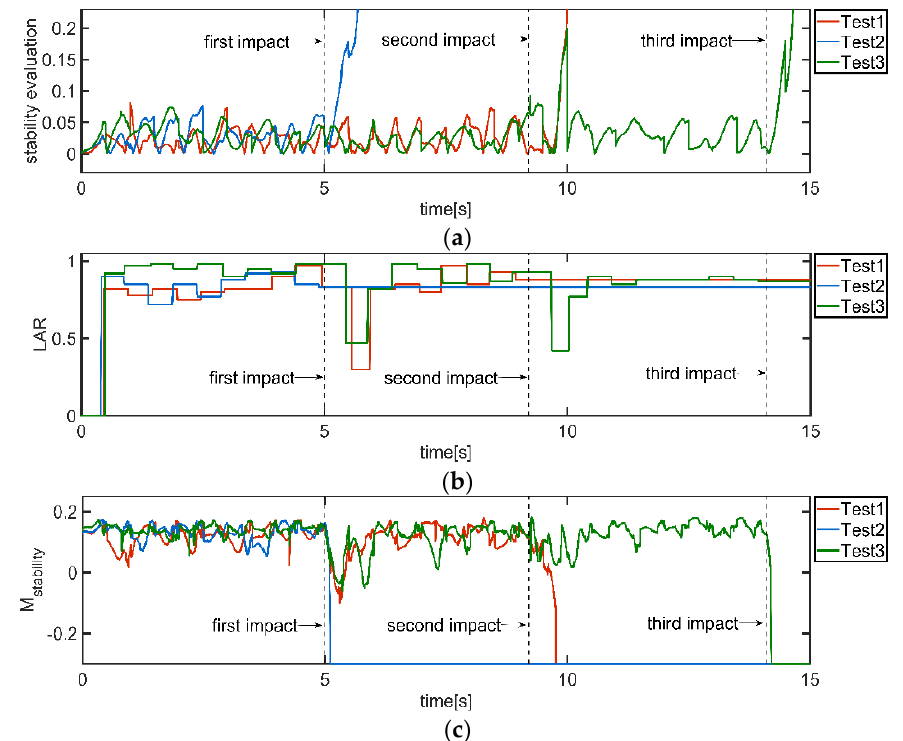
Figure 24. Stability measurements of the three methods: ( a ) Method 1; ( b ) Method 2; and ( c ) Method 3.